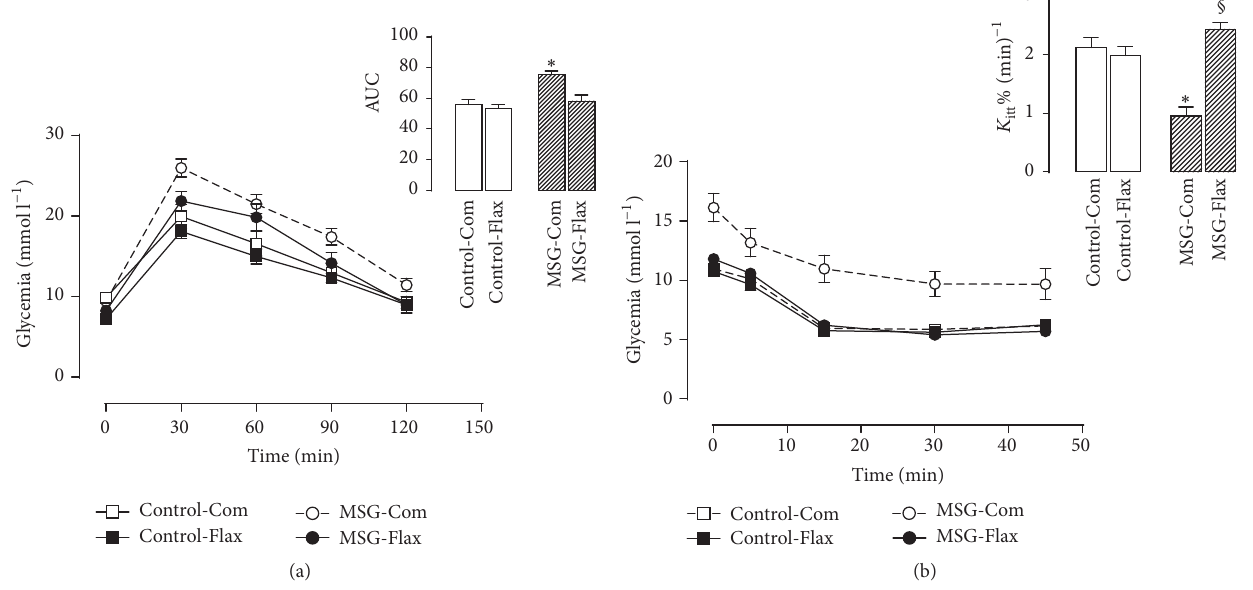
Figure 2: Effect of maternal flaxseed supplementation on offspring’s glycemia during the intraperitoneal glucose (a) or insulin (b) tolerance tests. The symbols represent the mean ± SEM of 5 different litters ( 𝑛 = 5 ) from each experimental group. The inset on each bar represents the area under the curve (AUC) from glycemia during the glucose tolerance test and 𝐾 itt obtained from the insulin tolerance test, respectively. Symbol over the bar represents the significant differences among the groups based on one-way ANOVA, where ∗ depicts statistical difference with 𝑃 < 0.001 among all groups and § 𝑃 < 0.001 depicts statistical difference compared to MSG-Com group.